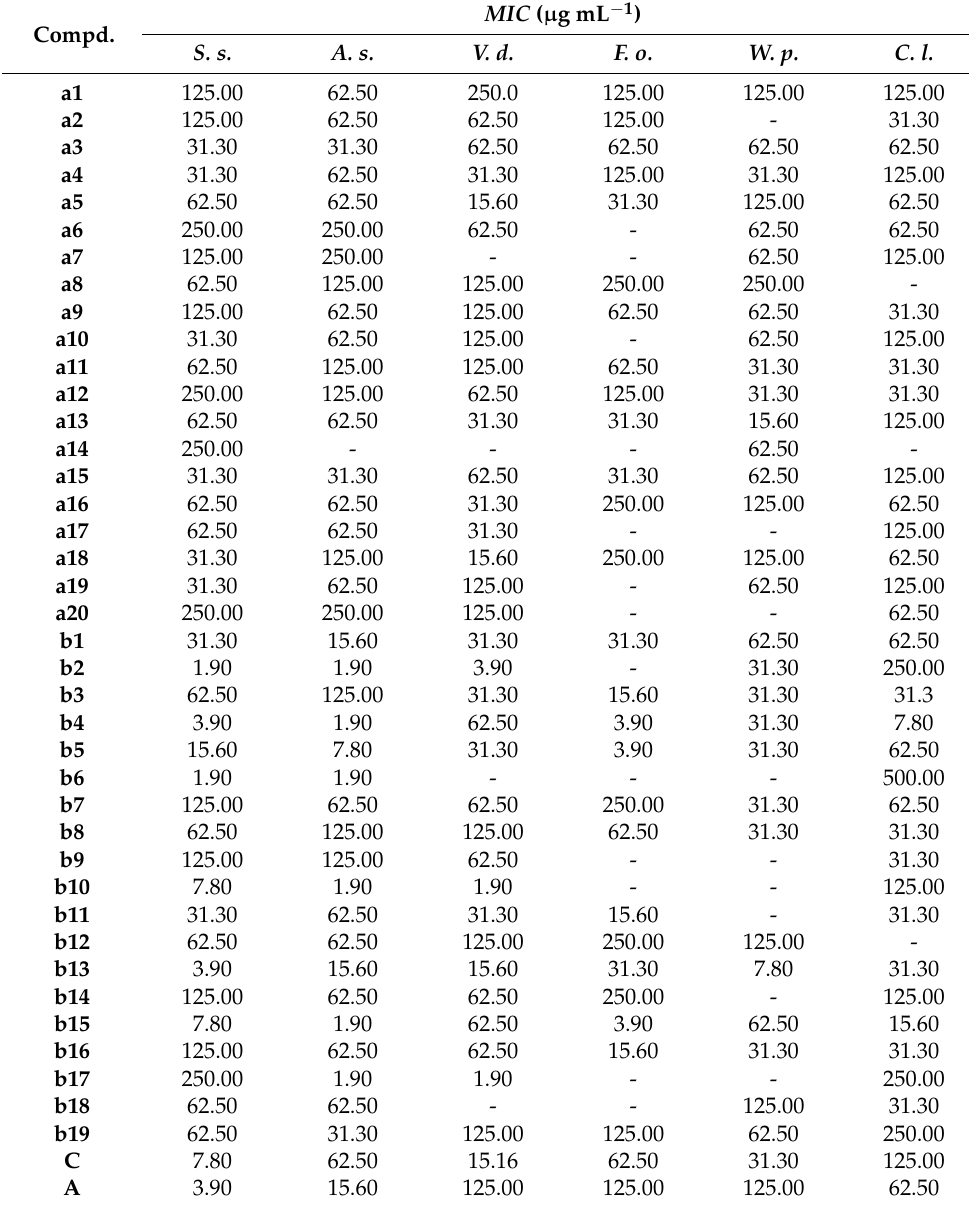
Table 1. MIC values of compounds against plant pathogenic